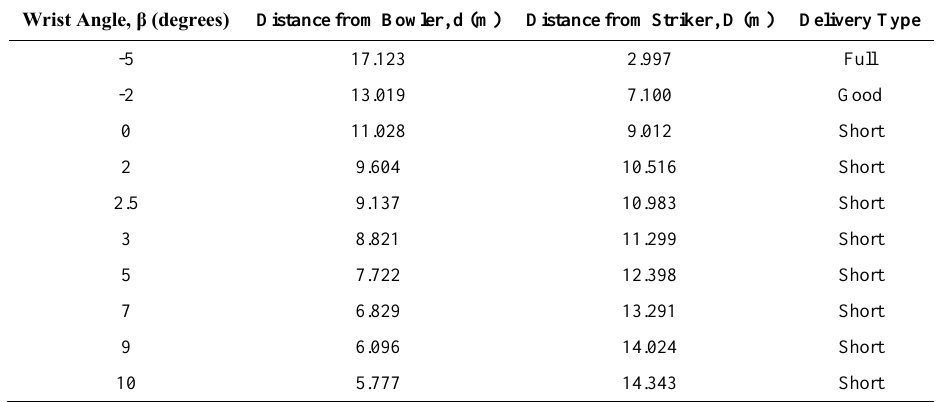
Table 1. Calculation of delivery lengths at varying wrist angles with V =35.8 m/s (80 mph), Φ = 82.03 0